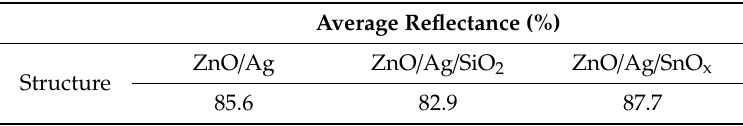
Table 1. Average reflectance according to the back structure.